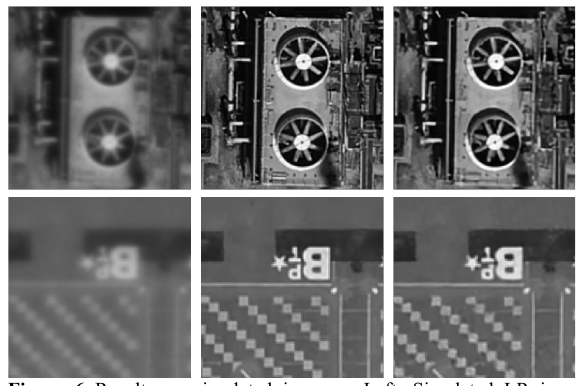
Figure 6 Results on simulated imagery. Left: Simulated LR image (30cm). Centre: Simulated HR image (15cm). Right: Output from model (15cm)